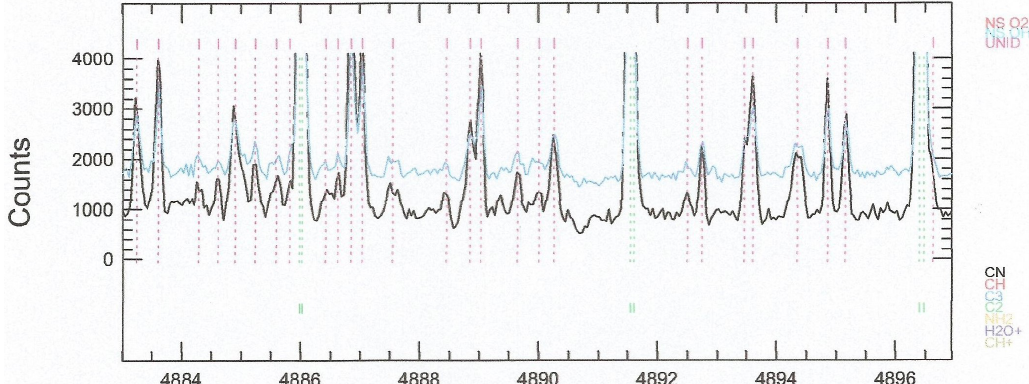
Figure 1. The Fragment of optical spectrum of 122P/deVico comet (Cochran & Cochran 2002). In the x axis – wavelengthes in angstroms. Black spectrum from 4 October 1995. Blue spectrum from 3 October 1995. Emission line lists and plots of 122P/de Vico comet spectra are available in digital format from the Planetary Data Systems Small Bodies Node.